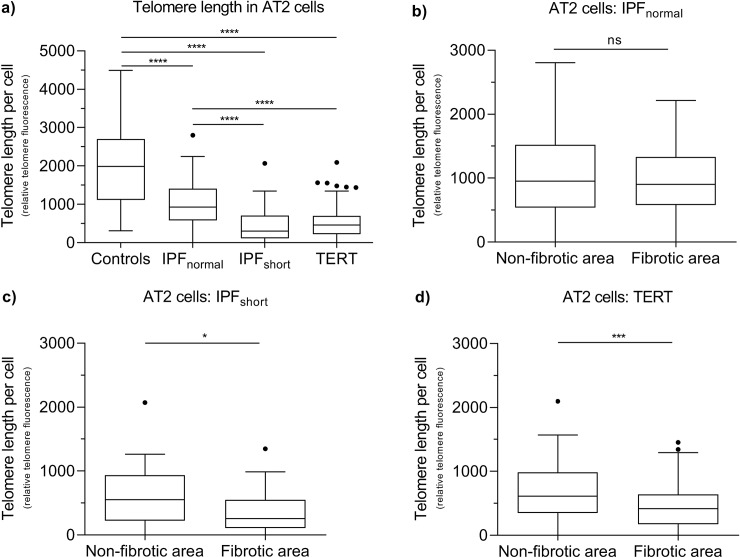
AT2 cell telomere length measured by fluorescence in situ hybridization (FISH) in 5 control, 5 IPFnormal, 5 IPFshort and 6 TERT lungs.(a) Tukey box-plots of telomere length measured in AT2 cells by fluorescence in situ hybridization (FISH). All patient groups showed significant shorter AT2 cell telomere length than in controls (p < 0.0001).Telomere length in the IPFshort group was significantly shorter than in controls (p < 0.0001) and in IPFnormal (p < 0.0001). Telomere length in TERT was also significantly shorter than in controls (p < 0.0001) and in IPFnormal (p < 0.0001). No difference in AT2 telomere length was present between IPFshort and TERT. Asterisks indicate significant differences calculated by Kruskal-Wallis multiple comparison tests. (b, c, d) AT2 cell telomere length in non-fibrotic and fibrotic lung areas in (b) IPFnormal, (c) IPFshort and (d) TERT lungs. In IPFnormal no difference was found between areas. AT2 cell telomere length in non-fibrotic areas was significantly longer than fibrotic areas in IPFshort (p = 0.0237) and TERT (p = 0.0001) lungs. Asterisks indicate significant differences calculated by Mann-Whitney analyses (ns = not significant, * = p < 0.05, *** = p < 0.001, **** = p < 0.0001). Boxes represent data between 1st and 3rd quartile and whiskers extend to the highest and lowest values of expression that are not considered outliers.